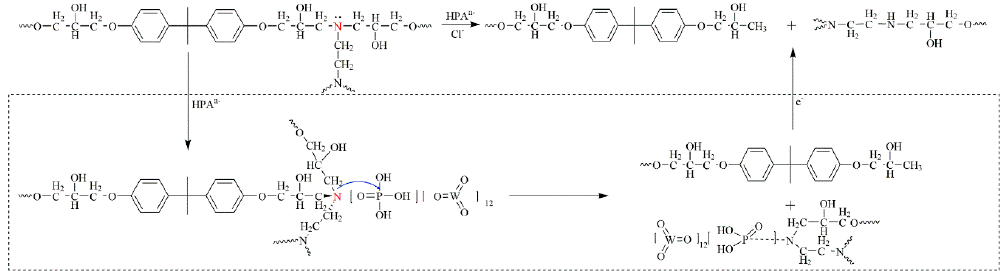
Figure 7. Possible electrochemical catalytic degradation mechanism of diglycidyl ether of bisphenol A/ethylenediamine (DGEBA/EDA) in the presence of heteropoly acids (HPA).